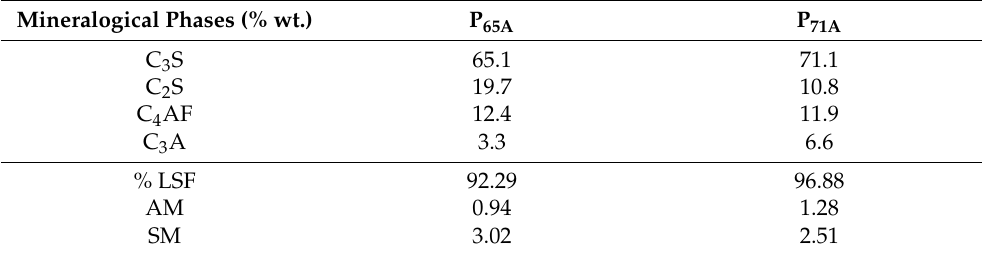
Table 3. Designed compositions of crystal phases for P 65A and P 71A based on Bogue equations. Mineralogical Phases (%